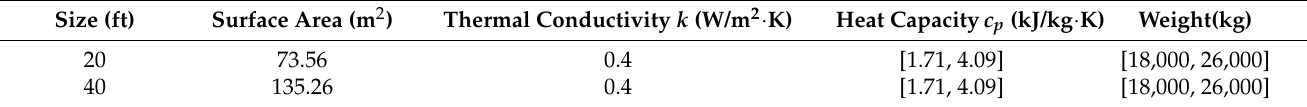
Table 2. Container Parameter.